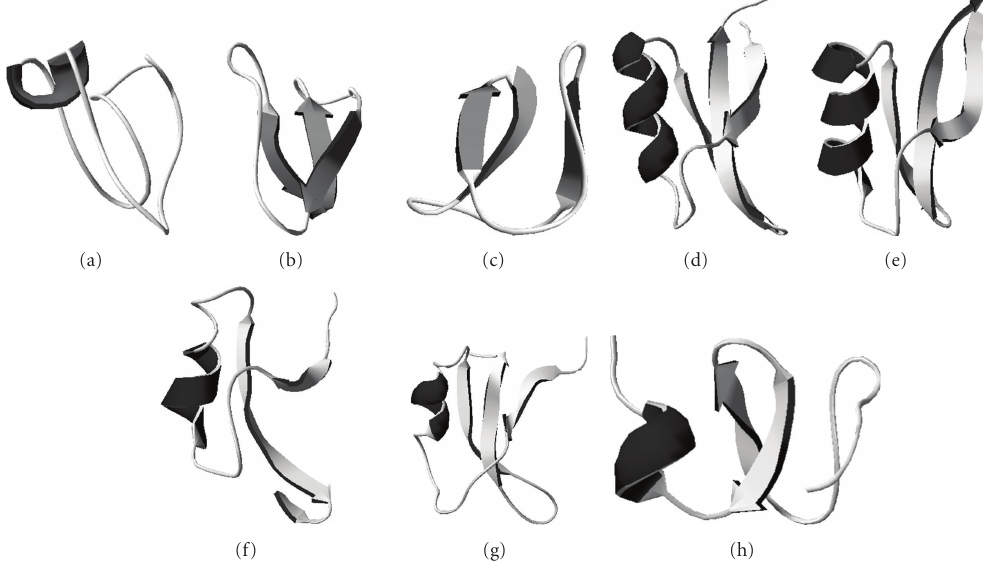
Figure 2: Three-dimensional structure of cyclotides (a) circulin A (PDB:1BH4); (b) circulin B (PDB:2ERI); (c) kalata B2 (PDB:1PT4); defensins (d) VrD1 (PDB:1TI5); (e) VrD2 (PDB:2GL1); (f) Ah-AMP1 (PDB:1BK8); (g) brazzein (1BRZ); and hevein-like (h) Ac-AMP2